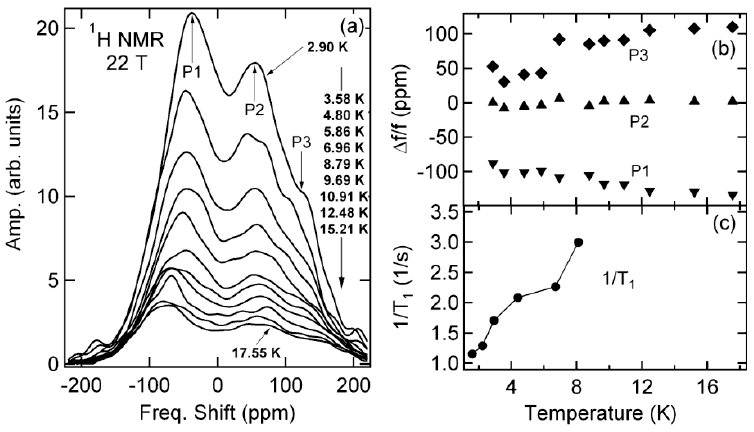
Figure 5. ( a ) Temperature dependent 1 H spectra of Per field B . (Center frequency = 935.95 MHz); ( b ) Temperature dependence of selected peak c features; ( c ) Temperature dependence of the spin relaxation